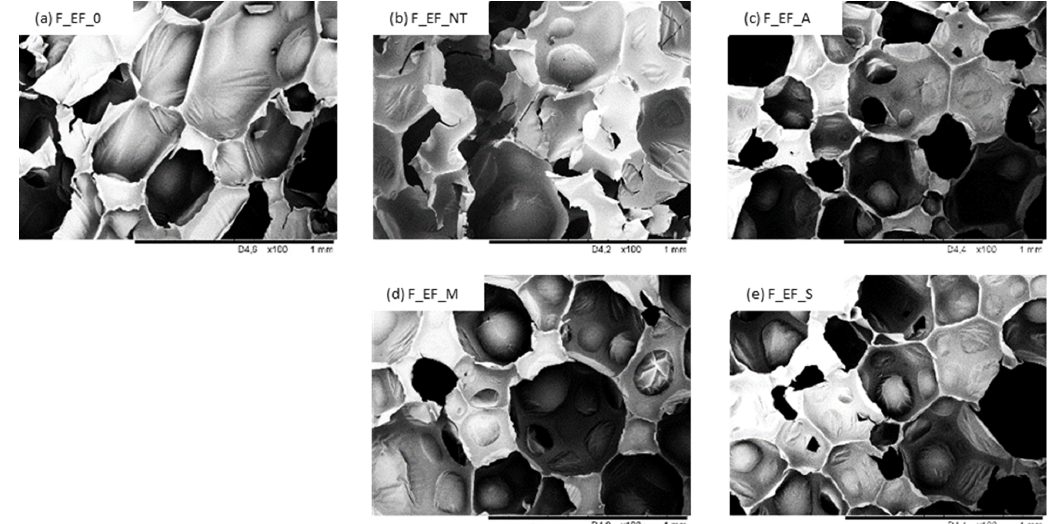
Figure 10. The morphology of ( a ) F_EF_0, ( b ) F_EF_NT, ( c ) F_EF_A, ( d ) F_EF_M, ( e ) F_EF_S observed at a magnification of × 100.